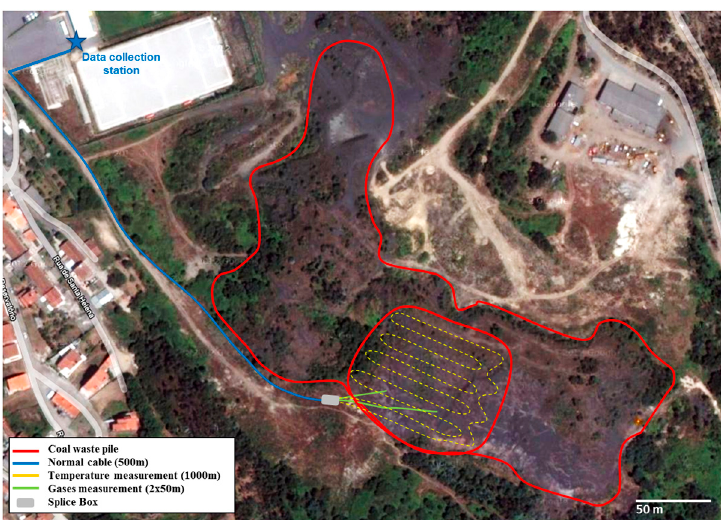
Figure 3. General view of the active combustion area in S. Pedro da Cova waste pile and schematic representation of the optical fiber system installation in the field (base map source: Google Earth ©2016 Google Image Landsat Data SIO, National Oceanic and Atmospheric Administration (NOAA), U.S. Navy, National Geospatial-Intelligence Agency (NGA), General Bathymetric Chart of the Oceans (GEBCO)).